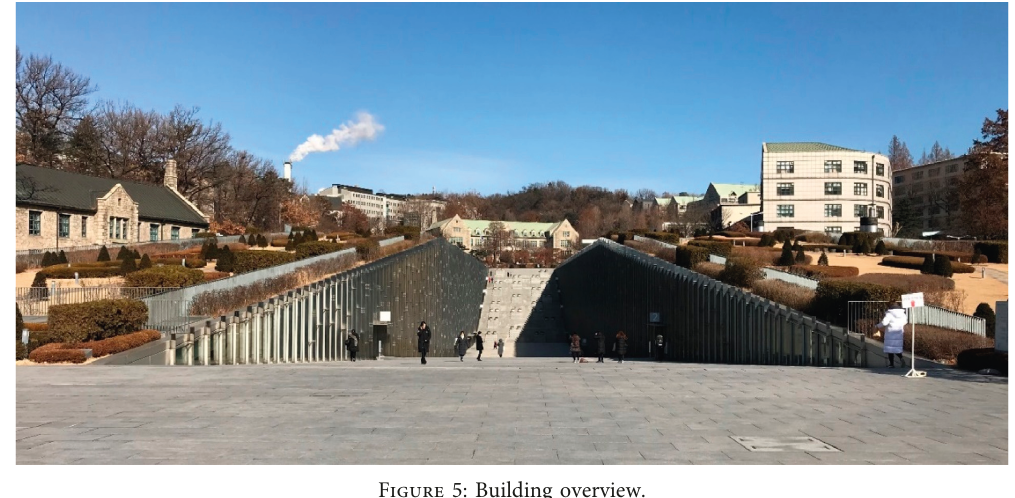
Figure 5: Building